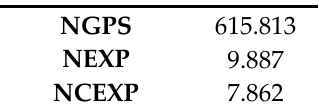
Table 2. Number of GPS readings (NGPS), number of reconstructed expeditions (NEXP), and number of validated expeditions (NCEXP).